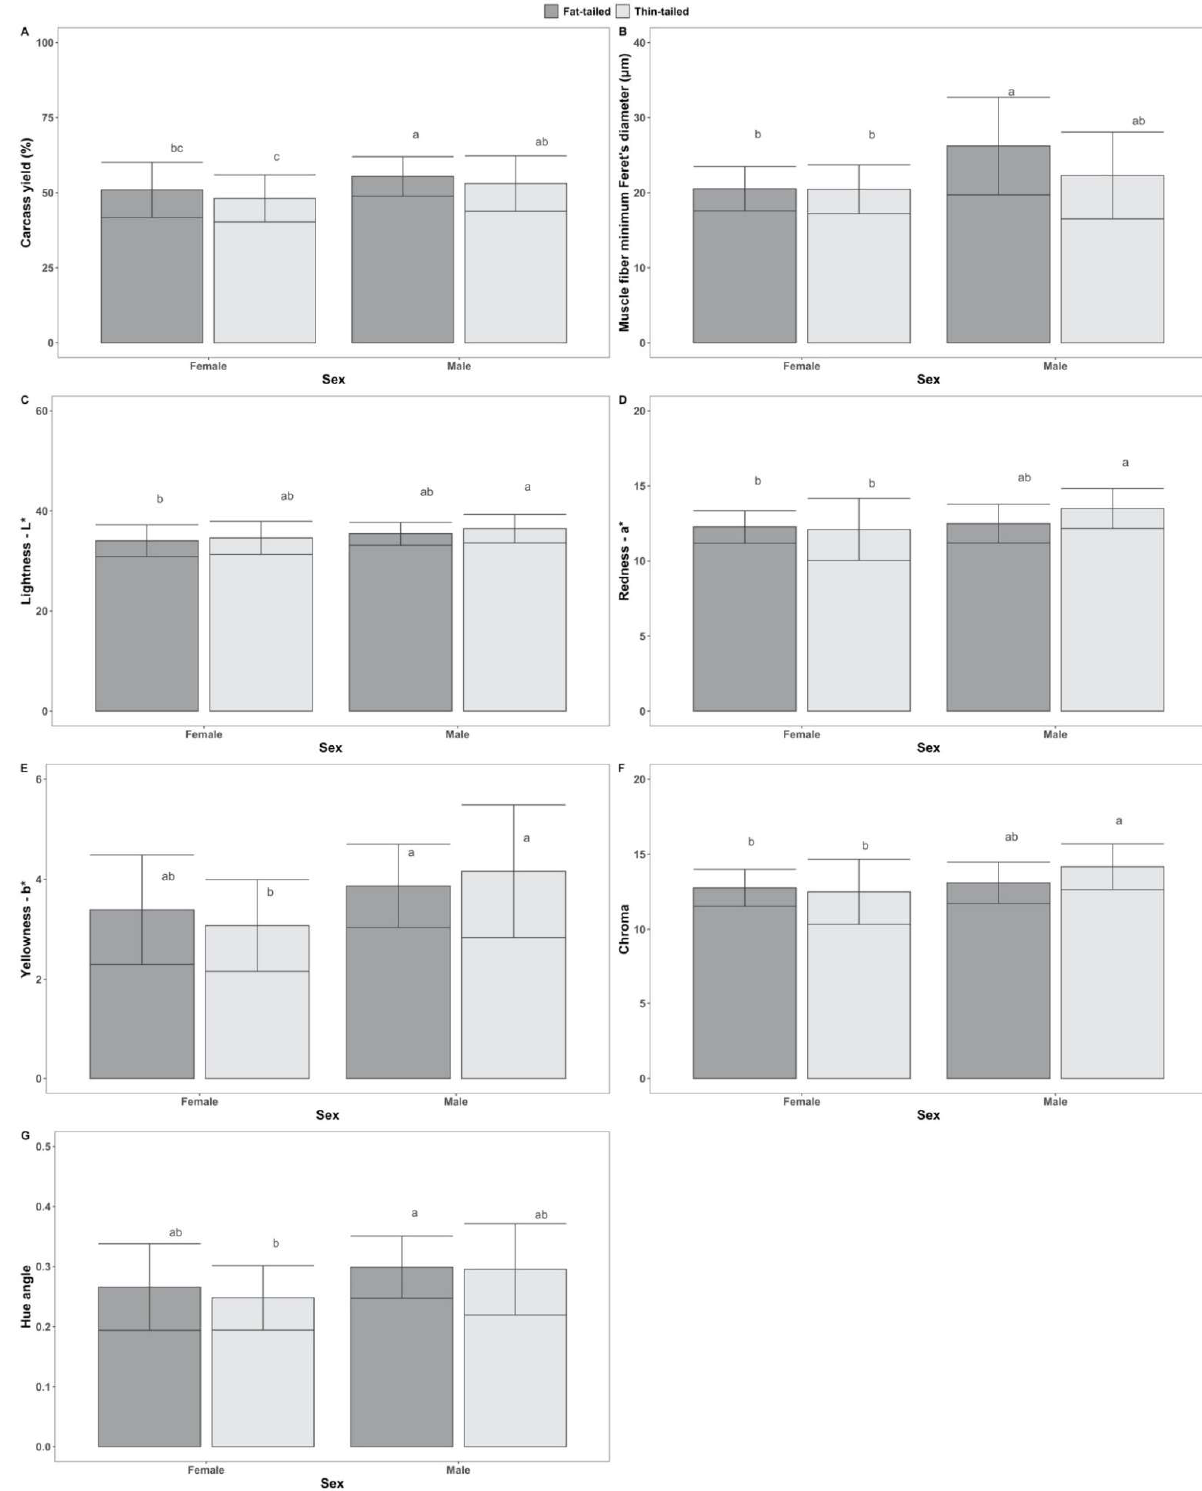
Figure 3. Tukey’s post hoc tests for pairwise comparisons between groups, following two-way ANOVA, accounting for the effect of the interaction between sex (male, female) and sheep populations (fat-tailed, thin-tailed) on the tested traits: ( A ) Carcass yield—as %; ( B ) Muscle fiber minimum Feret’s diameter—in μm; ( C ) Lightness—L*; ( D ) Redness—a*; ( E ) Yellowness—b*; ( F ) Chroma; ( G ) Hue angle. Superscripts not sharing any common letter between groups indicate statistically significant differences ( p <